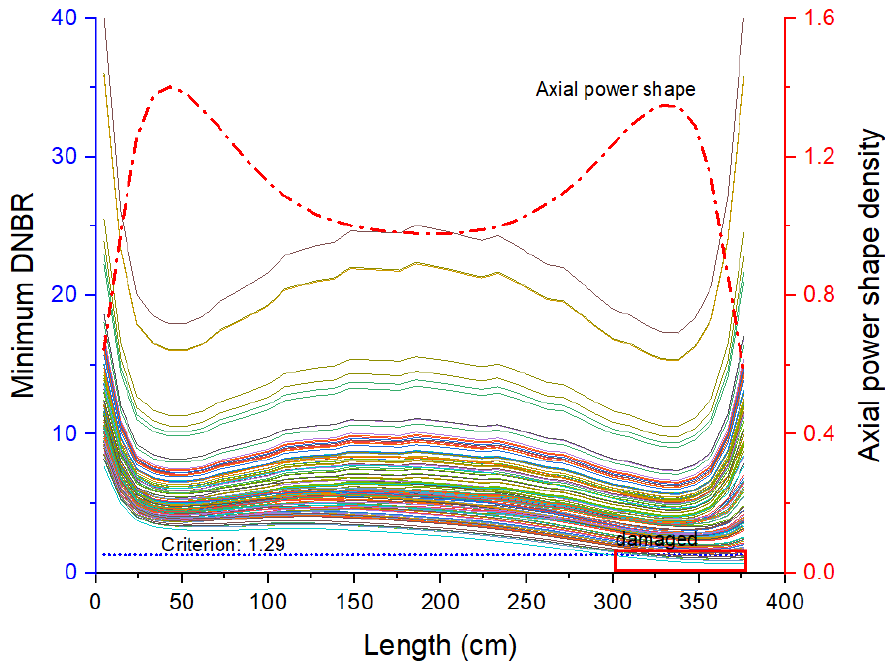
Figure 10. The minimum DNBR on the axial length of 14 assembly groups (124 runs).